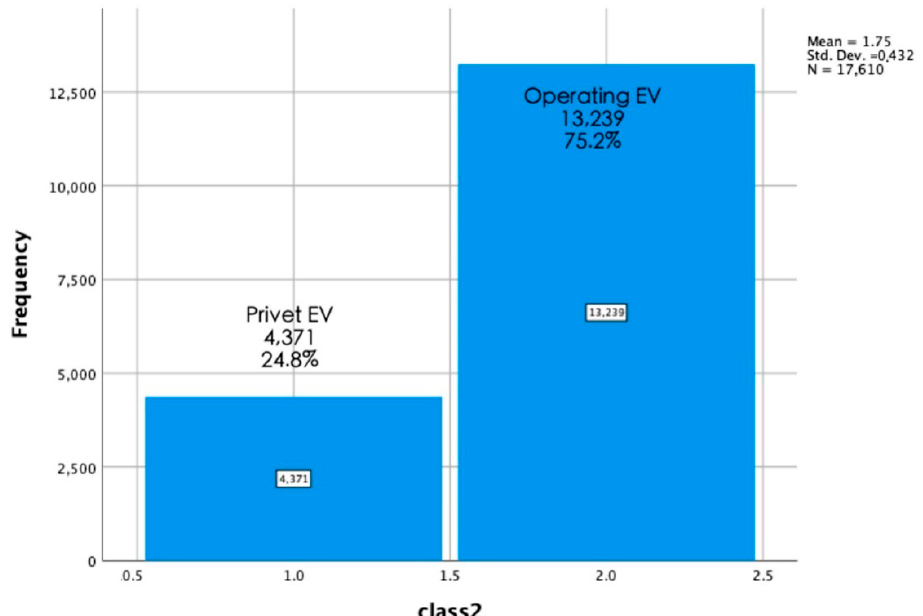
Figure 4. Comparison chart of EV operating models.